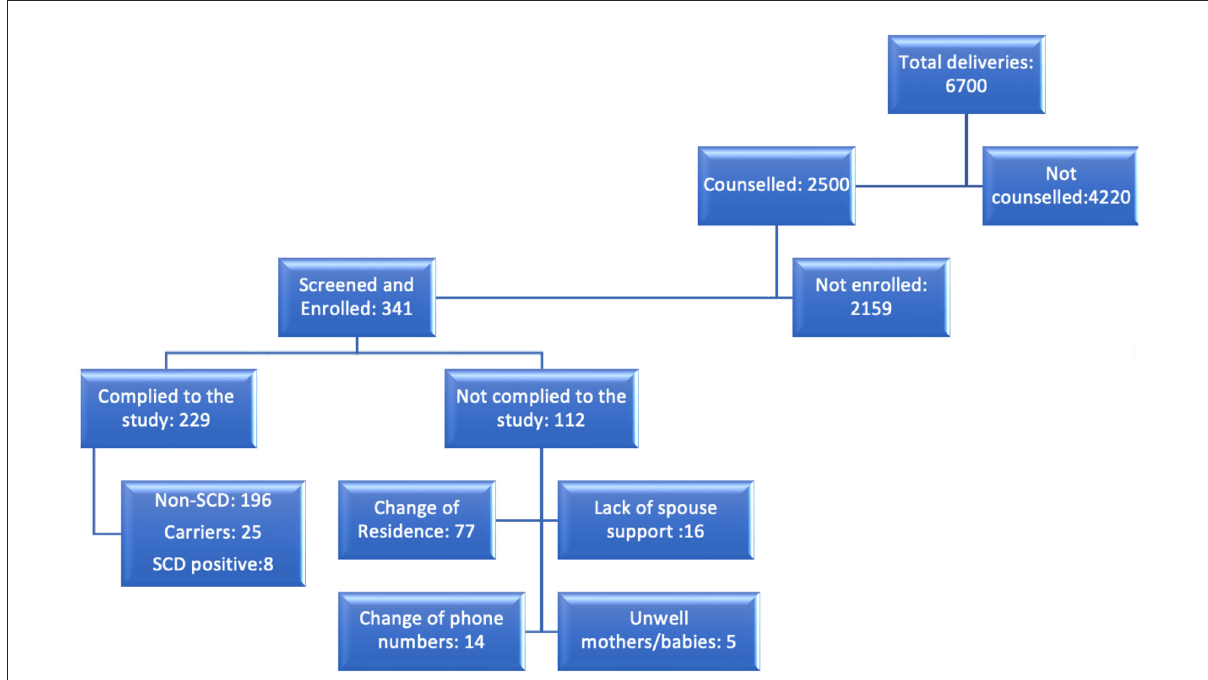
FIGURE2 A flow chart showing the flow of events/steps and involved individuals on each of these. The deliveries reported here are between the period of January 2020 and September, 2021.